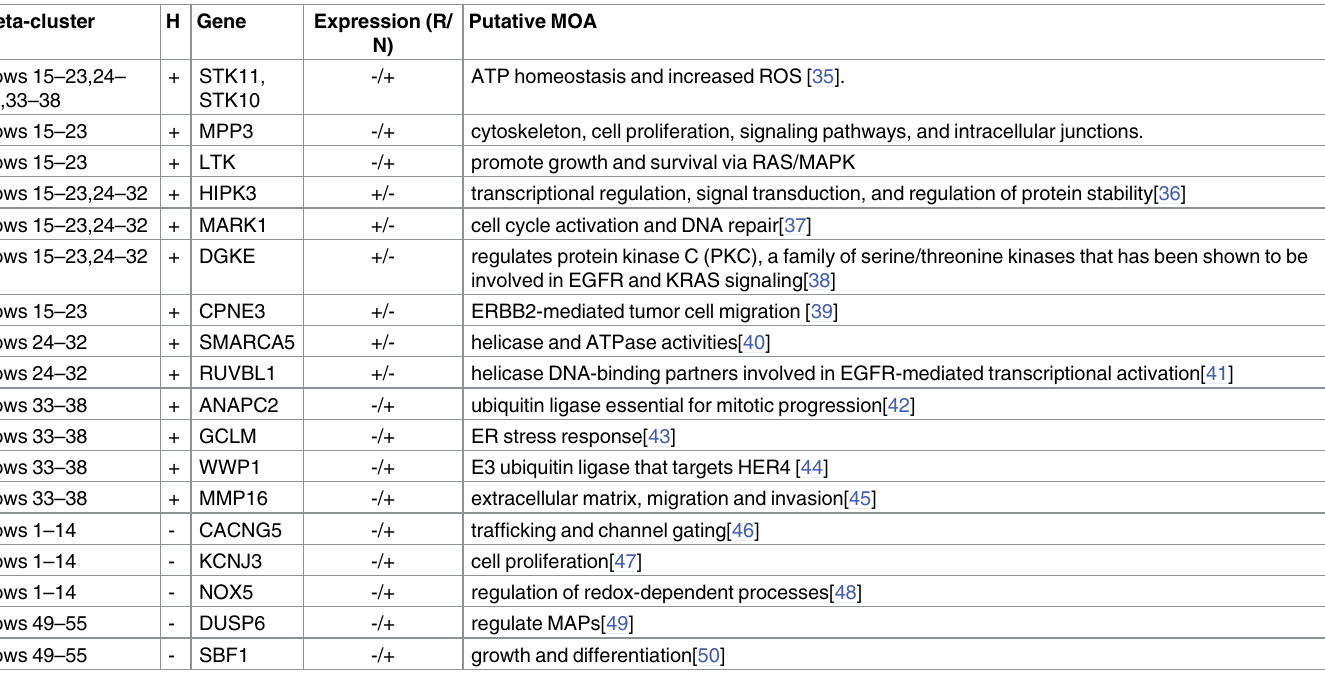
Table 1. Summaryof the potential erlotinib biomarker genes identified using pathway fitness scores. Column1 identifiesthe meta-cluster as viewed in Fig 4 . Column2 list whetherthe pathway fitness score is positive (+) or negative(-). Column3 lists the gene. Column4 lists the differentialgene expression comparing responders(R) to non-responders(N). Over expressionin respondersis indicatedby a +/-, and vice versa for over expressionin non-responders. Column5 lists the putative MOAs.